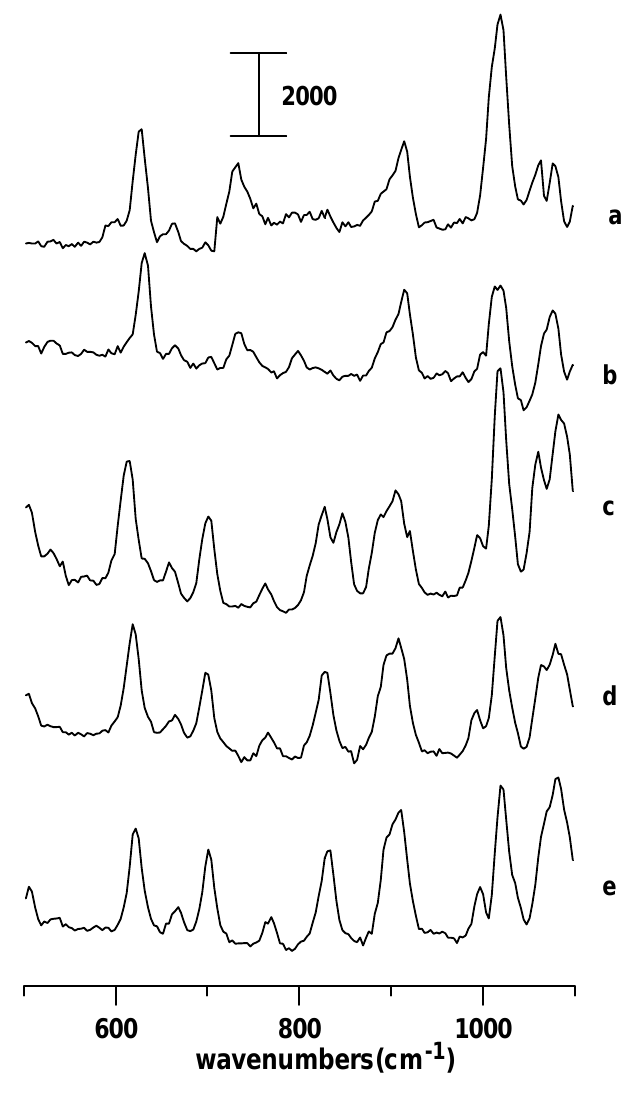
Figure 4. Pressure dependence of the Raman spectra of 1-butyl-3-methylimidazolium chloride in the Crystal 1 form under the following pressures: (a) ambient, (b) 0.3, (c) 0.3 (after 24 hours), (d) 0.9, and (e) 1.5 GPa.